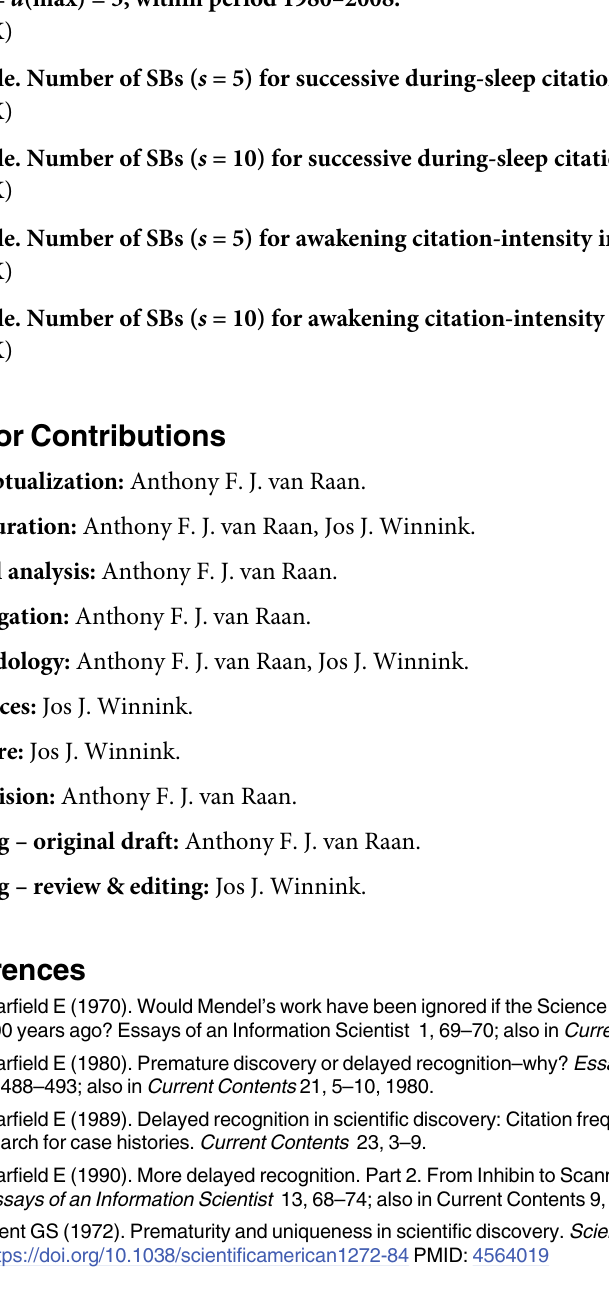
(max) = 1) in the medi- s (max) = 1, c (min) = 5, a s a